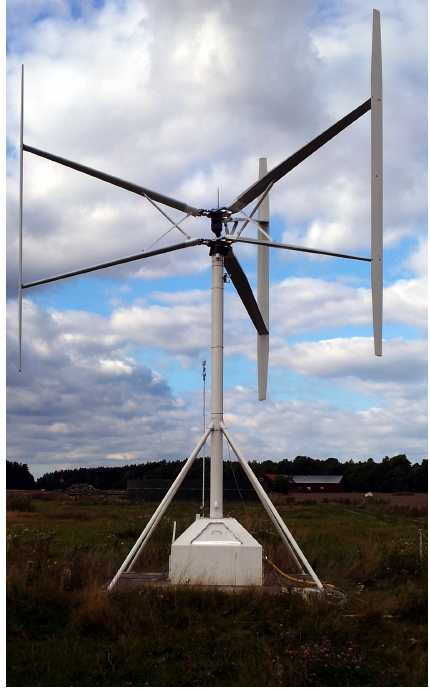
Figure 4. The 12-kW turbine with installed load cells and